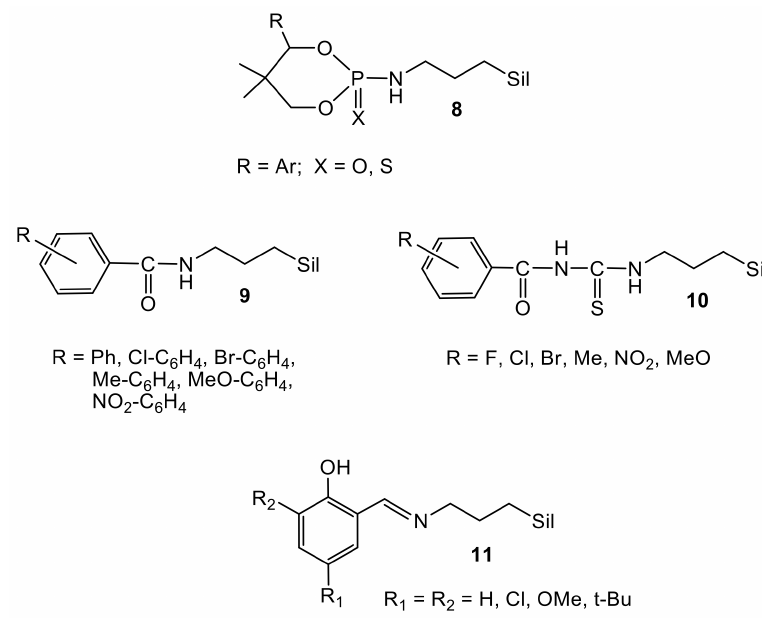
Figure 4. Chemical structures of silatranyl antifungal agents ( 8 – 11